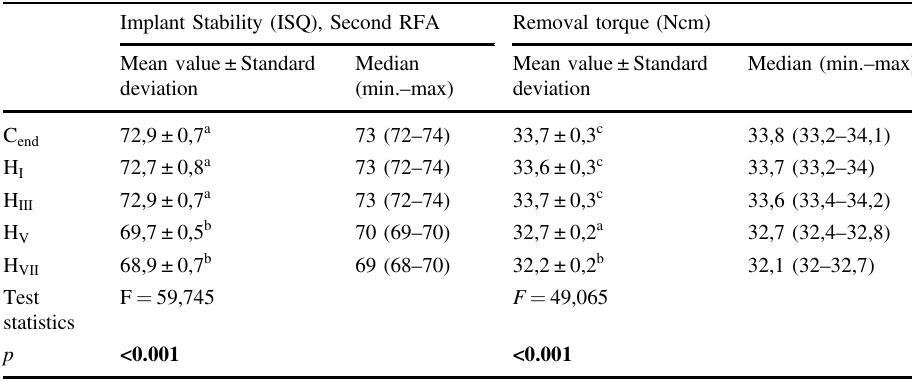
Implant Stability (ISQ), Second RFA